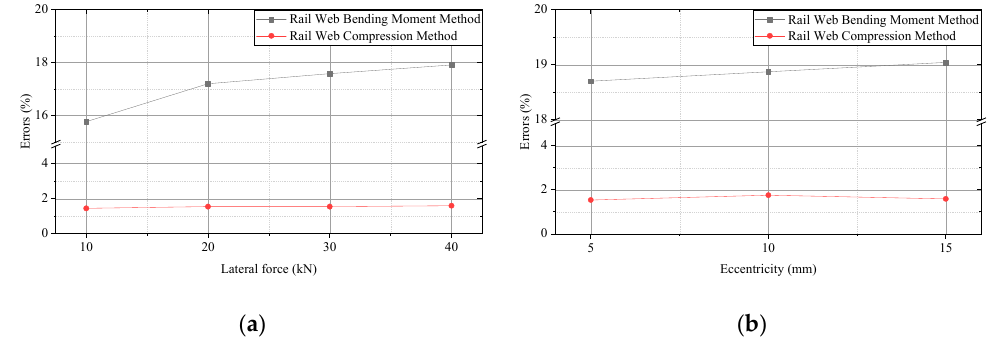
Figure 10. Influences of wheel-rail contact states on different layout schemes: ( a ) Influences of lateral force; ( b ) influences of lateral eccentricity.